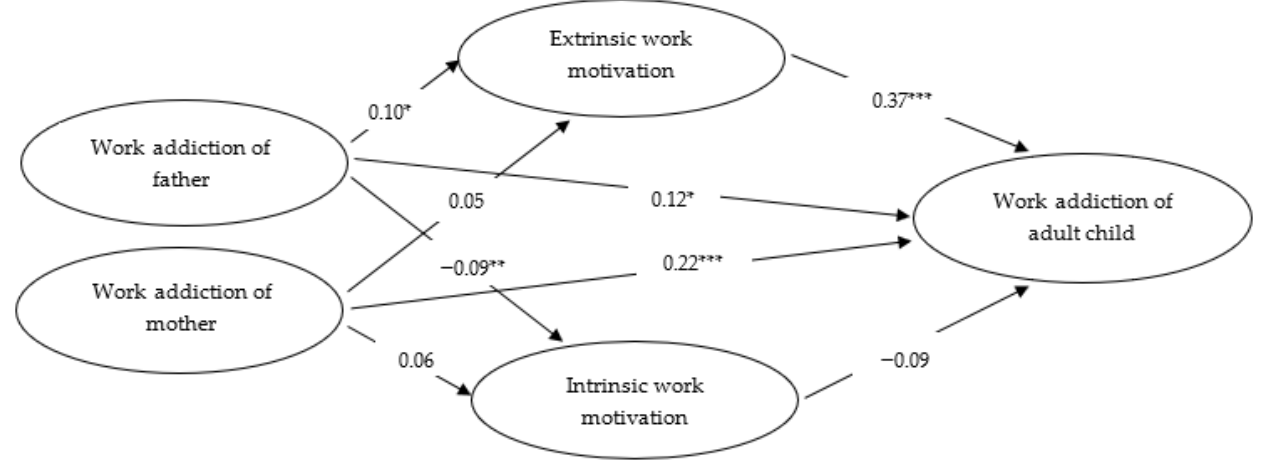
Figure 1. Proposed model linking perceived work addiction of parents and work addiction of an adult child (via intrinsic and extrinsic motivations). Note: The values in the model represent standardized regression weights; * p < 0.05, ** p < 0.01, *** p < 0.001.